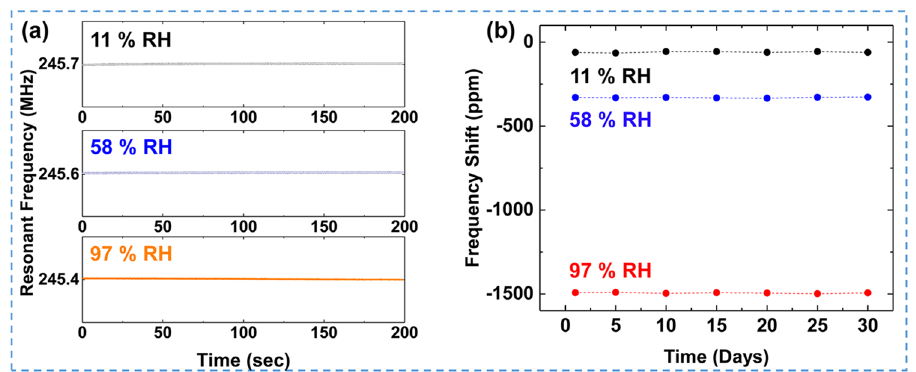
Figure 4. ( a ) The short-term stability test of 250 MHz_10 min sensor under the different RH levels. ( b ) The long-term stability test of the SAWR sensor for 30 days of